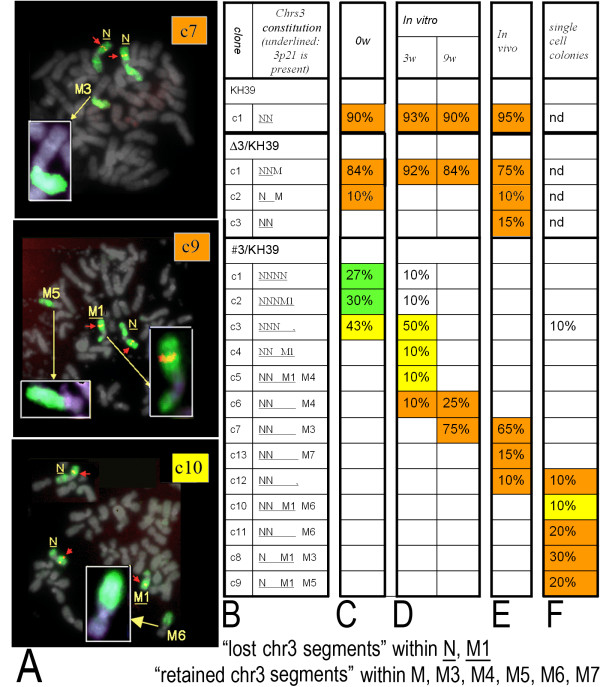
Clonal changes in KH39, Δ3/KH39 and #3/KH39. A. Dual-color FISH defines chr3 constitution (see explanation to figure 2A and 2B) for c7 in the #3/KH39, 9 weeks of in vitro propagation, and for c9 and c10, representing single cell colonies of the #3/KH39. Marker chromosomes are shown magnified. Orange text box with clone number (c7, c9): clones without supernumerary 3p21 copy. These have two RP6-123I13 signals (red arrows) per metaphase. Yellow text box: clone (c10) with one supernumerary 3p21 copy. It shows three RP6-123I13 signals per metaphase. B. Chr3 constitution for each clone includes N (cytogenetically normal chr3) and M, M1, M2 ... M7 (different marker chromosomes). Underlined: the present or lost chromosome had 3p21 FISH signal. C-F. Percentages of metaphases representing a particular clone at 0, 3 and 9 weeks of propagation; in all analyzed SCID tumors and in 10 single cell colonies (not done for KH39 and Δ3/KH39, "nd"). The tumors that derived from #3/KH39 and Δ3/KH39 have been analyzed previously [8]. Orange, yellow and green shading: expanded clones with no, 1 and 2 supernumerary 3p21 copies, respectively, compared to KH39. The term "expanded clone" refers to a clone that appeared at the given time or its representation was not decreased (ratio >0.8) compared to the previous time point. No shading: decreased representation compared to previous time point. Empty: clone is not present in the sample. Note that chr3 fragments, which were carried by N and M1, were lost in more than one clone expanded during growth ("lost chr3 segments"), whereas ones included into M, M3, M4, M5, M6 and M7 were retained as extra chr3 copies in the expanded clones ("retained chr3 segments").